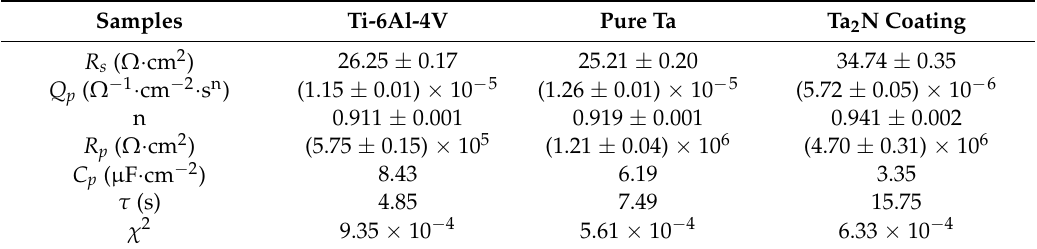
Figure 10. Electronic equivalent circuit (EEC) used in the fitting procedure of the EIS experimental data. Table 2. Electrochemical parameters derived from impedance fitting for investigated specimens at their respective open circuit potentials in Ringer’s physiological solution at 37 °C.